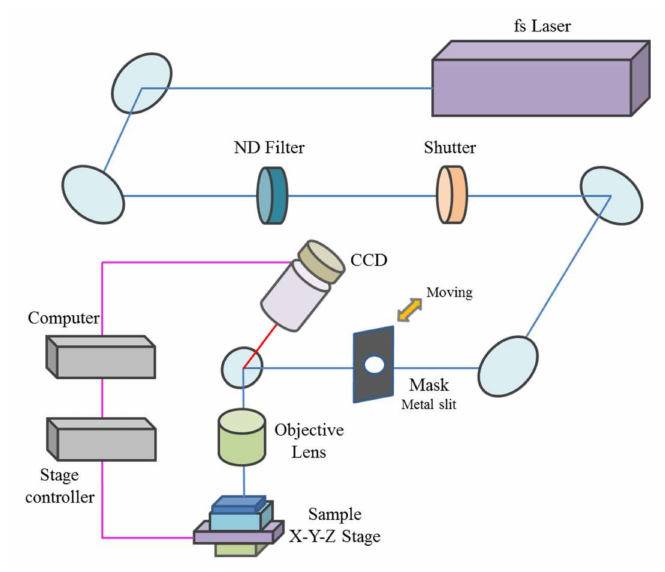
Figure 1. Schematic of the femtosecond laser patterning